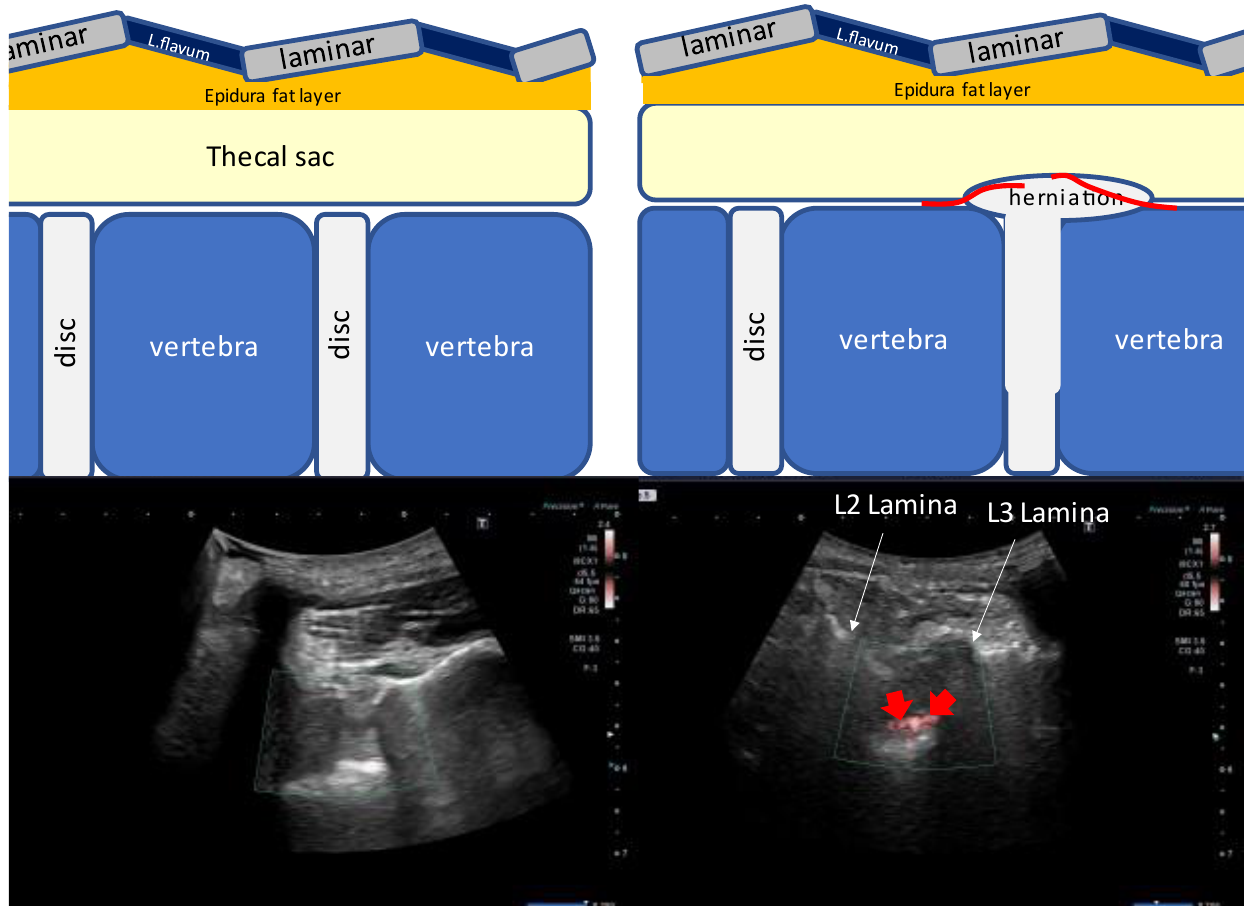
Figure 9. Paramedian sagittal oblique sonogram of the lumbar spine. Pulsatile SMI signal associated